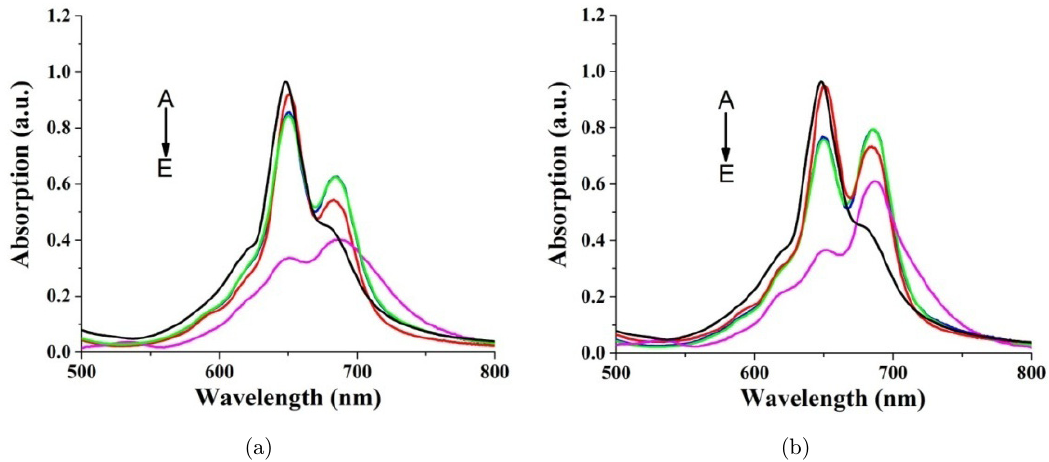
Fig. 5. E®ects of HE, IB and TRP on absorption spectra of AlPc-BSA system. (a) The AlPc/BSA ratio is1/1. A – E represents AlPc (black, 1 (cid:1) 10 (cid:2) 5 mol/L), AlPc þ BSA þ TRP (red, 1:1:1000), AlPc þ BSA þ IB (blue, 1:1:20), AlPc þ BSA (green, 1:1) and AlPc þ B- SA þ HE (pink, 1:1:20). (b) The AlPc/BSA ratio is 1/10. A – E represents AlPc (black, 1 (cid:1) 10 (cid:2) 5 mol/L), AlPc þ BSA þ TRP (red,